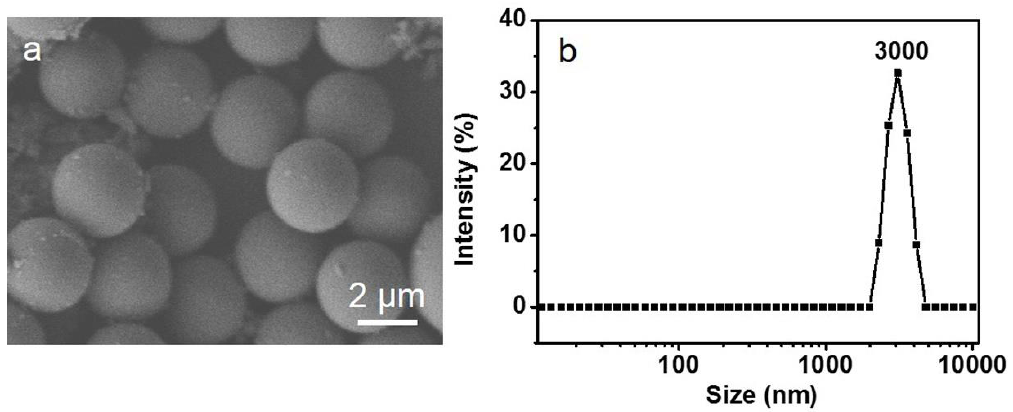
Figure 3. ( a ) SEM image and ( b ) dynamic light scattering (DLS) data of PS microspheres with 0.1% w / v